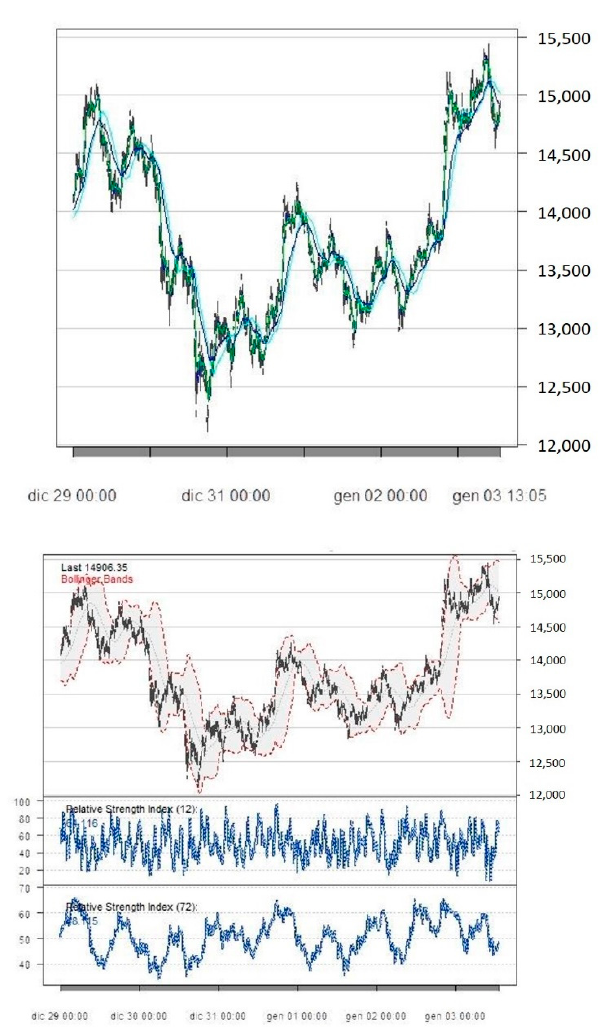
Figure 3. Intraday strategies: highlight for the period 29 December 2017 to 3 January 2018; SMA12 and SMA72 ( top panel), RSI12 and RSI72 ( bottom panel).